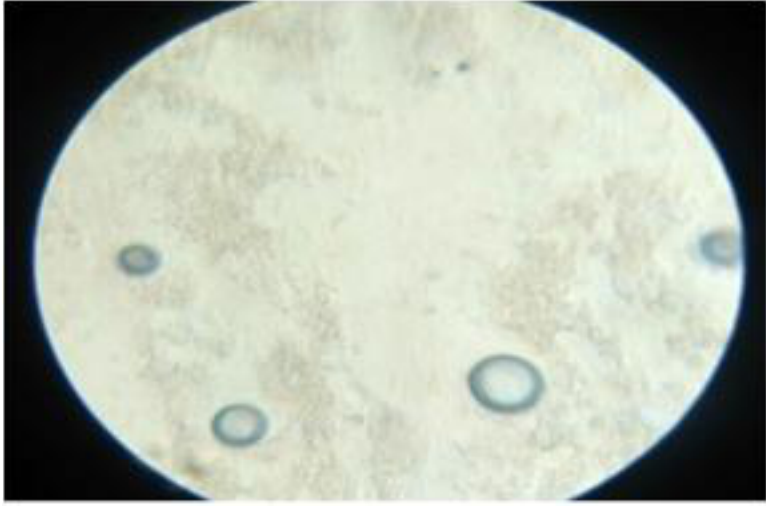
Figure 5. Microscopic vesicular image of optimized transferosome-loaded proanthocyanidin.